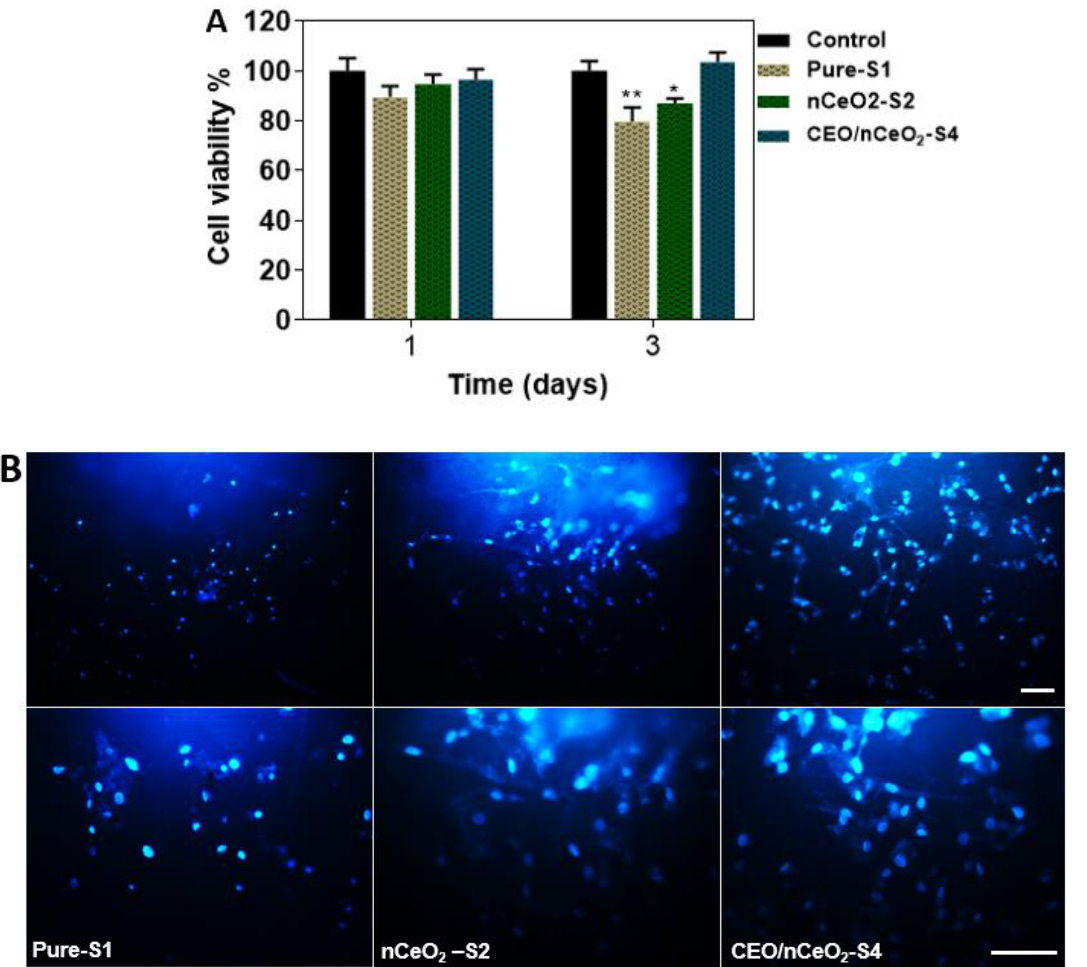
Figure 7. MTT assay of nanofibrous mats at 1 and 3 days, ( A ) and fluorescence images showing the proliferation of ADMSCs on the nanofibrous mats using DAPI staining after 3 days ( B ). Scale bar: 100 µm. Data are expressed as average ± SD. * p < 0.0332; ** p < 0.0021, versus control.